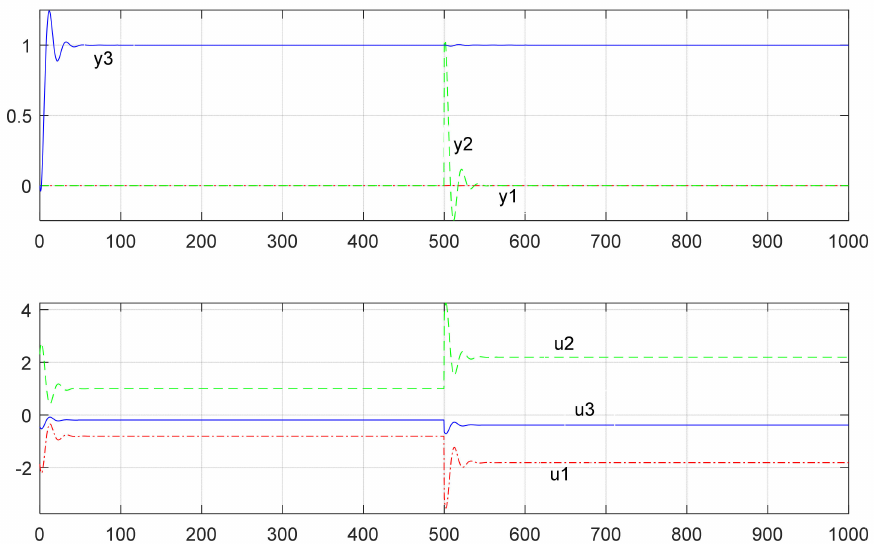
Figure 4. Reference tracking and disturbance regulation with considerate pre-compensation. Upper plot shows the system outputs y 1 , y 2 , and y 3 , as functions of time. Lower plot shows the system inputs u 1 , u 2 , and u 3 , as functions of time. All references and output disturbances in Figure 1 are zero, except r 3 = σ ( t ) and d 2 = σ ( t − 500 ) , where σ ( t ) is the unit step function (or rather distribution) at time t =